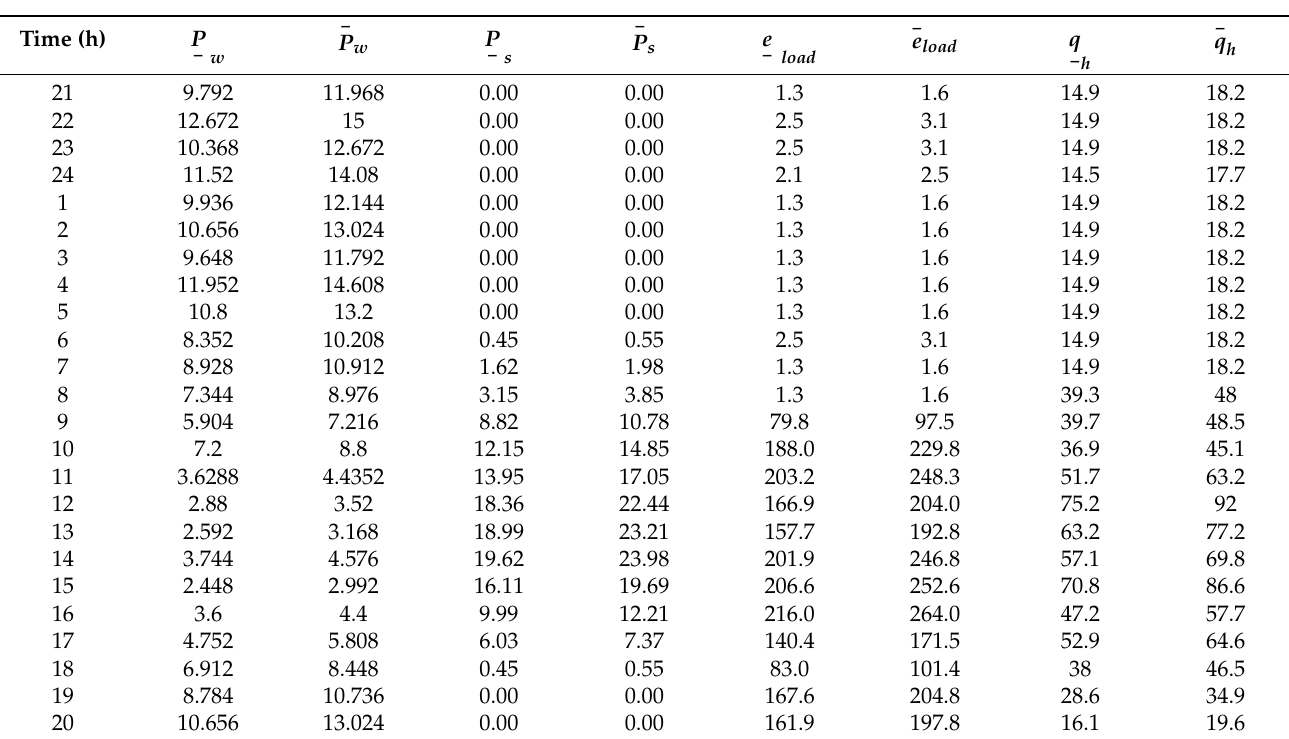
Table 3. Grey domain settings of P w , P s , e load , q h